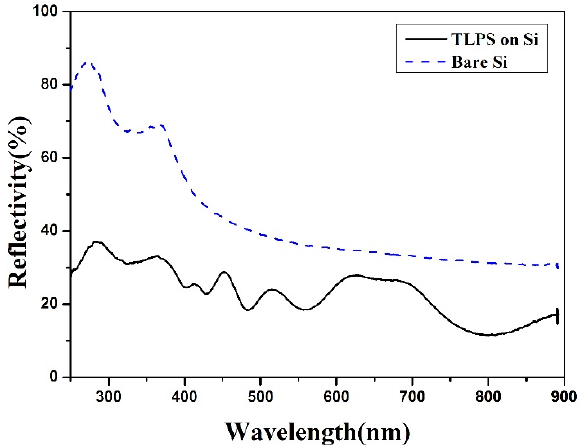
Figure 6. The spectral reflectance of the TLPS structure on a Si substrate and the bare Si